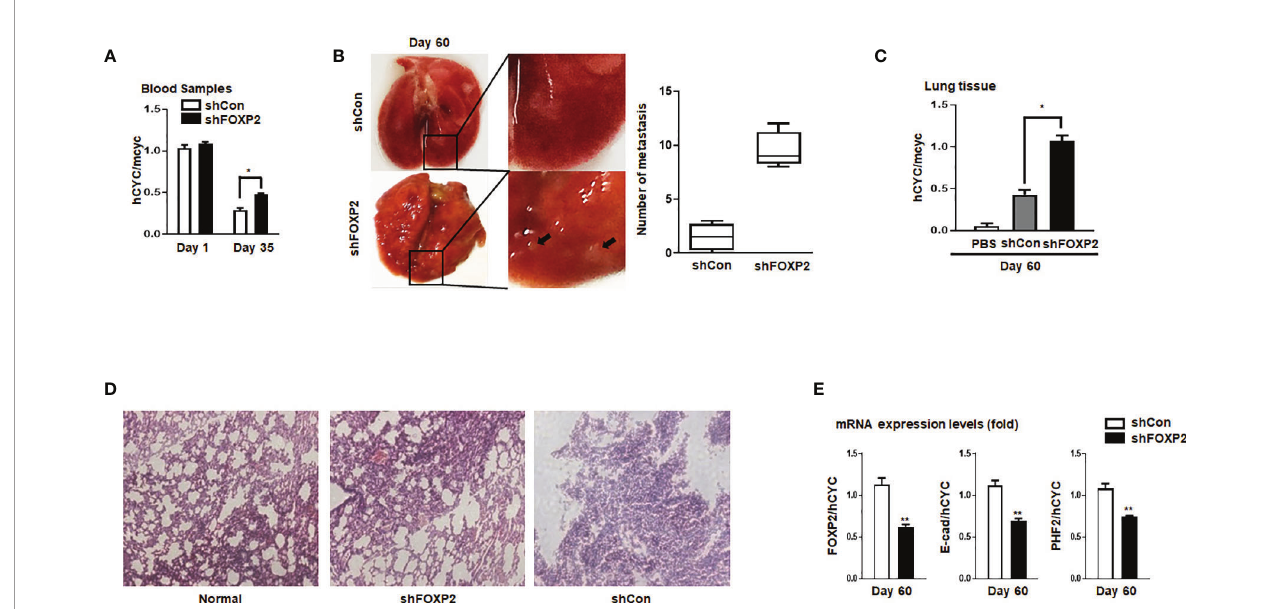
FIGURE 5 | Stable knockdown of FOXP2 stimulated the metastasis of breast cancer cells in vivo . The metastasis models of human breast cancer cells in nude mice were created via tail vein injection of control lentivirus-infected MCF-7 (shCon) cells or FOXP2-knockdown MCF-7 cells (shFOXP2) (2×10 5 cells/mouse). The mice (n=12 for each group) were sacri fi ced at day 1, day 35, and day 60 post-injection. (A) The stable knockdown of FOXP2 in cells increased the number of circulating tumor cells in the blood of model mice. Total RNAs of blood of each mouse were isolated at day 1 and day 35 post-injection and the relative concentration of human tumor cells in blood was determined by qPCR for the mRNA levels of human speci fi c CYCLOPHILIN over the mRNA levels of mouse speci fi c Cyclophilin. (B, C) Increased tumor formation was found in the lungs of mice injected with shFOXP2 cells. Representative photographs of the lung of the two groups of mice day 60 post-injection were shown, and the statistical data of the tumor foci number are presented on the right (B) . Total RNAs of the lung of each mouse were isolated at day 60 post-injection and the relative concentration of human tumor cells in lung was determined by qPCR for the mRNA levels of human speci fi c CYCLOPHILIN over the mRNA levels of mouse speci fi c Cyclophilin (C) . (D) H&E staining histological images of the lung of the two groups of mice. (E) The expression of exogenous human FOXP2, E-cadherin, and PHF2 in lungs of nude mouse metastasis models of human breast cancer cells. The total RNAs of lungs of different groups were isolated and the ratio of mRNA levels of human FOXP2, E-cadherin and PHF2 over human CYCLOPHILIN were determined by qPCR. The asterisks indicate statistically signi fi cant changes: *P ≤ 0.05, **P ≤